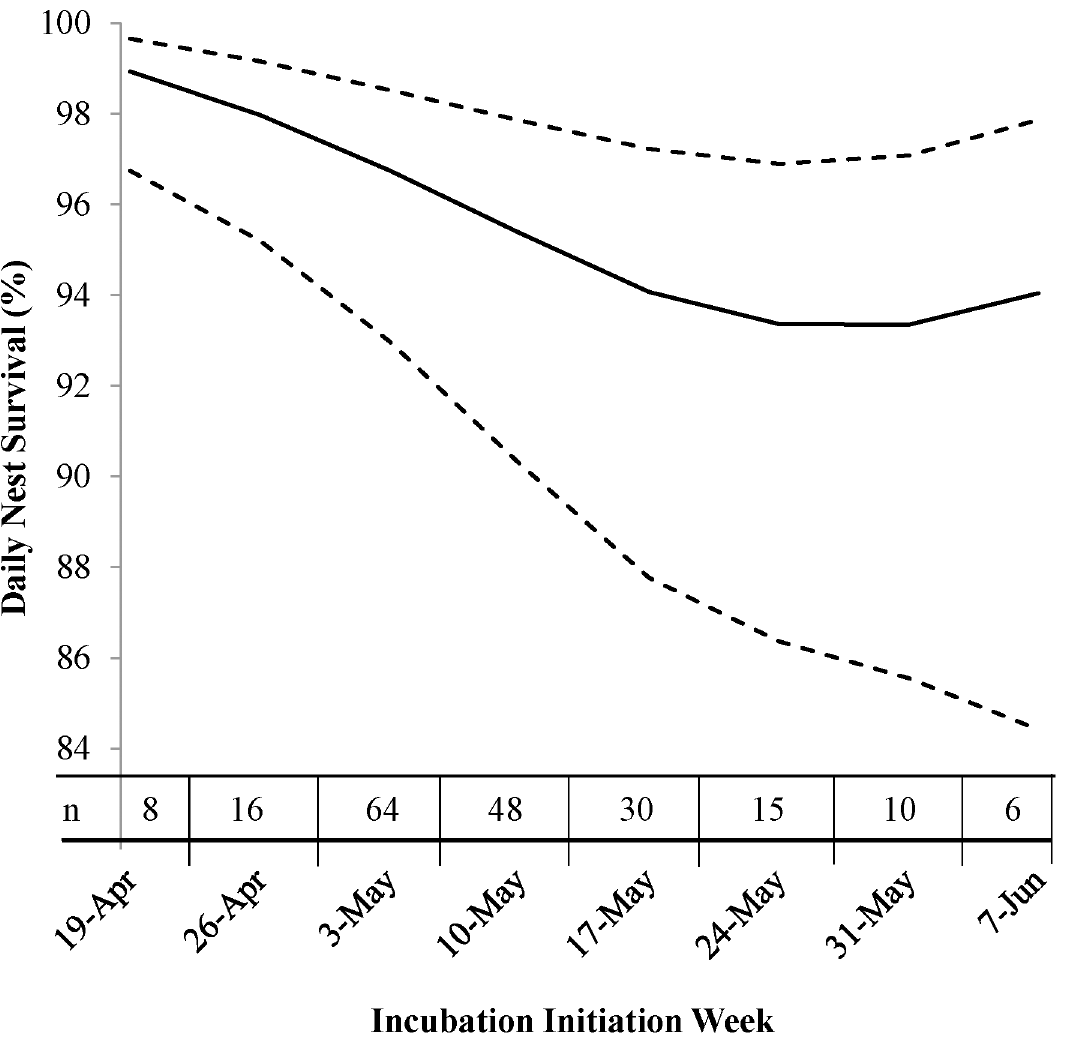
Fig 3. Daily nest survival rates (%) for Gunnison Sage-Grouse by incubation initiation (start week) for two populations in southwest Colorado, USA from 2005 – 2010. Estimates are from the model that includes year, start week, and nest age. 95% confidence intervals are shown as dashed lines and sample size by start week are shown on the